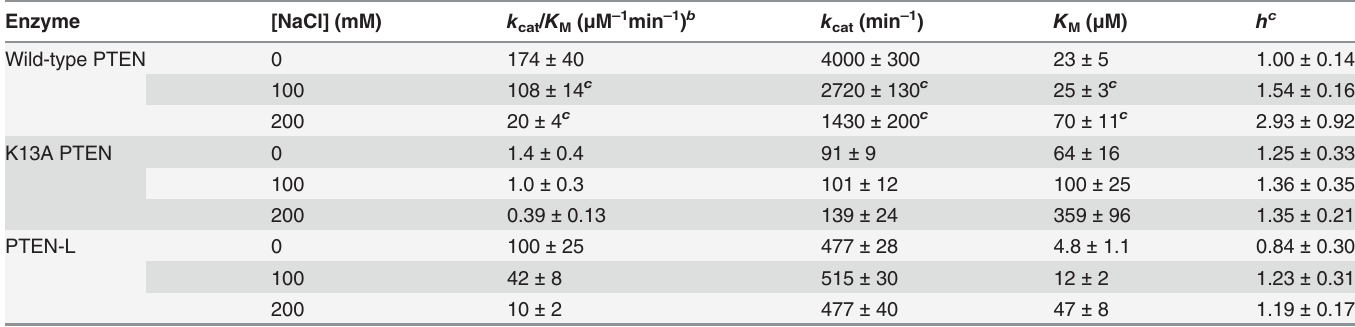
Table 1. Kinetic parameters for catalysis by wild-type PTEN, K13A PTEN, and PTEN-L a . Enzyme [NaCl]